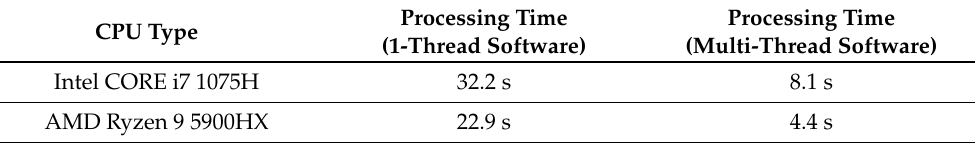
Figure 27. The display of two vessels (rounded in red) that were very close to each other ( left ) and zoomed display of these vessels ( right ). Table 6. The average segment processing time obtained by the implemented detection software.